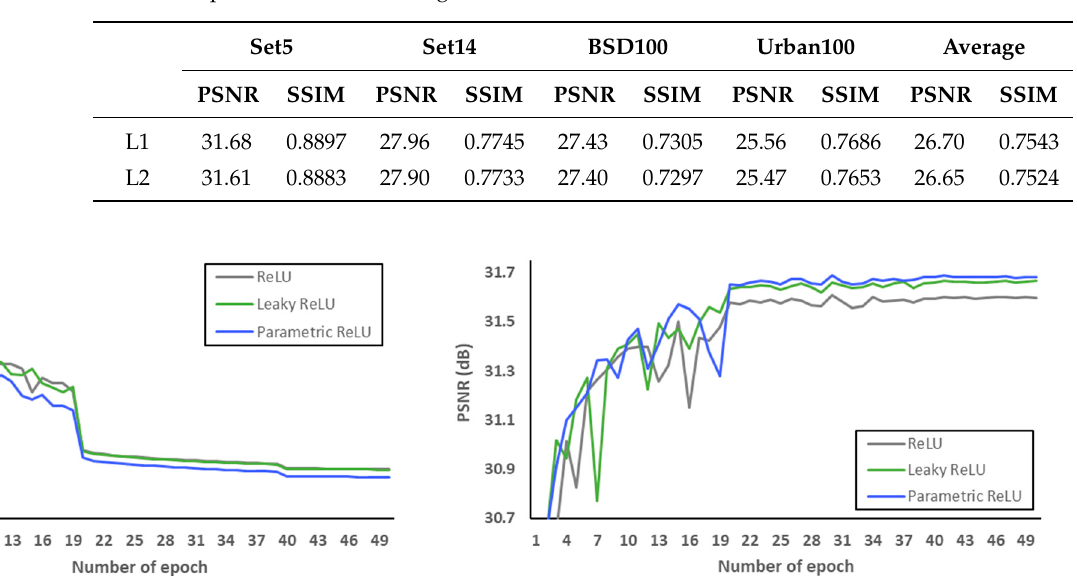
Figure 8. Verification of loss functions. Table 6. SR performances according to loss functions on test datasets.